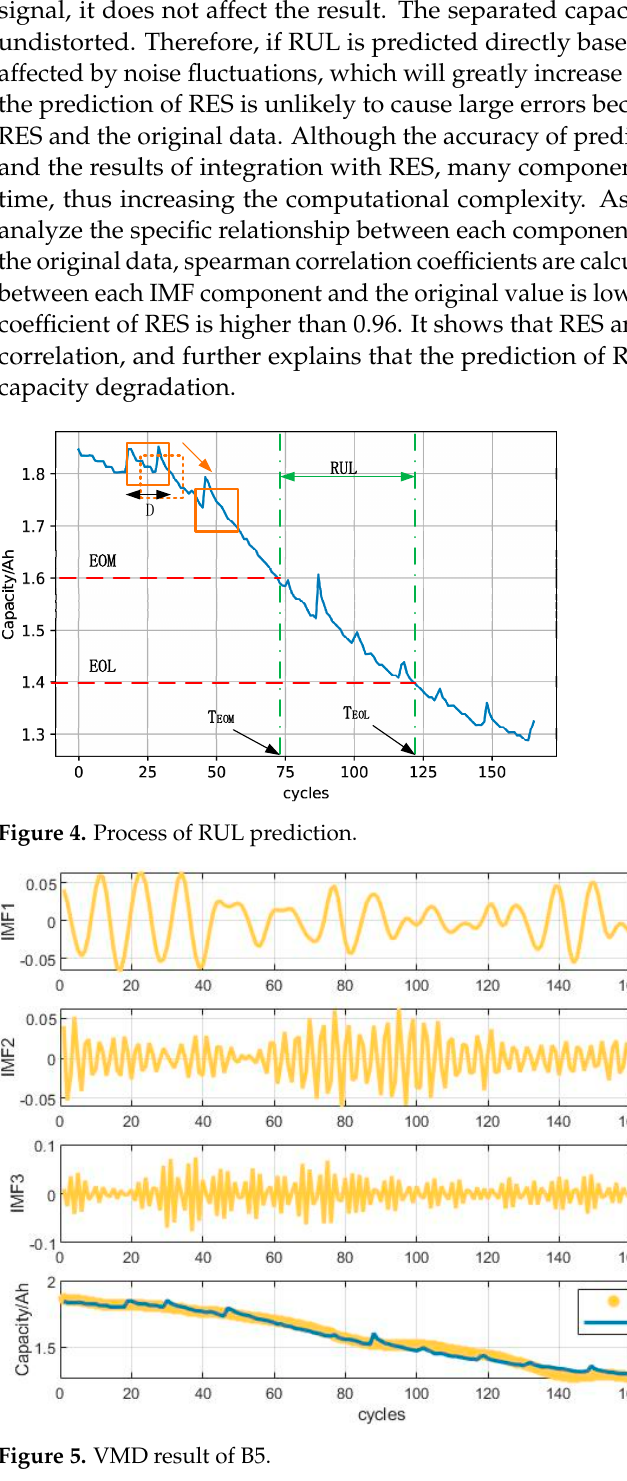
Figure 6. VMD result of CS34.